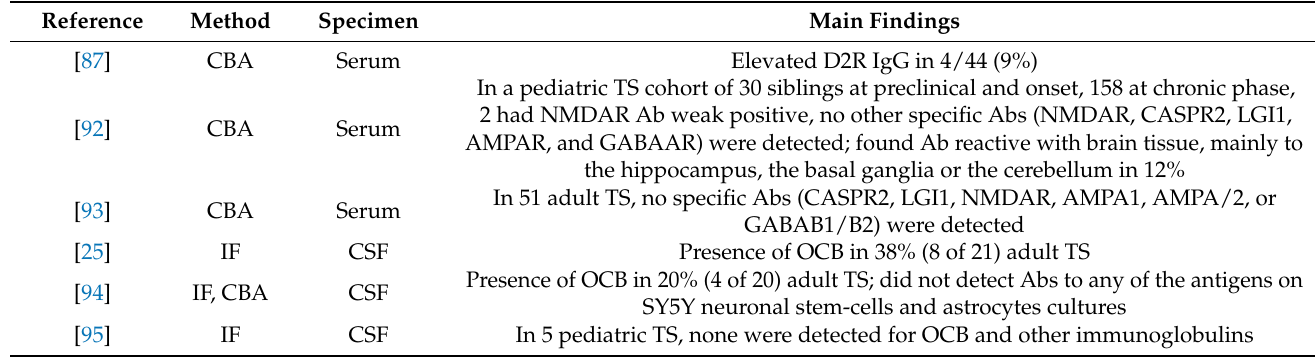
Abbreviation: AMPAR: α -amino-3-hydroxy-5-methyl-4-isoxazolepropionic acid receptor; Abs: antibodies; CASPR2: contactin-associated protein 2; CBA: cell-based assay; CSF: cerebrospinal fluid; D2R: dopamine-2 receptor; GABAAR: Gamma-aminobutyric acid type A receptor; GABAB1/B2: Gamma-aminobutyric acid B1/B2 receptor; IF: isoelectric focusing; IgG: immunoglobulin G; LGI1: leucin-rich glioma-inactivated protein; NMDAR: N-methyl-D-aspartic acid receptor; OCB: oligoclonal band; TS: Tourette